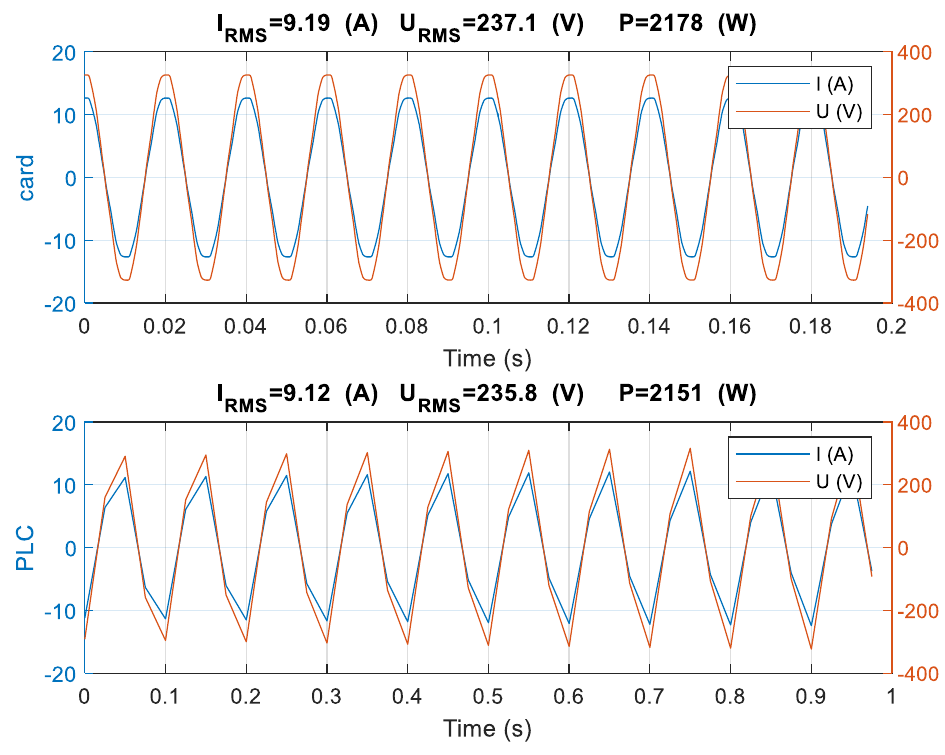
Figure 5. Samples of sinusoidal signals taken with card and PLC with average RMS values of current, voltage, and average values of power.